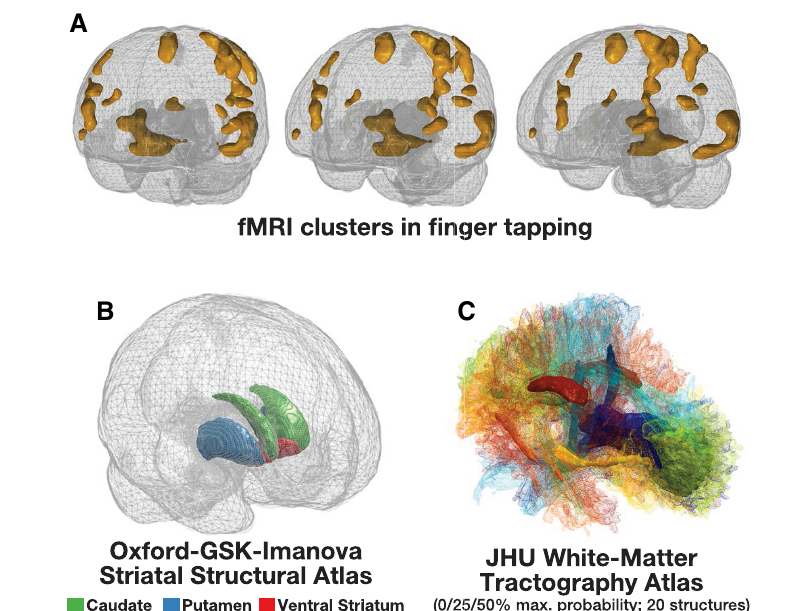
Figure 7. Additional examples of 3D renderings of MRI data. ( a ) Glass brain rendering of fMRI clusters associated with finger tapping, based on data from Gorgolewski et al. (2013), from three perspectives. ( b ) Glass brain rendering of the anatomical ROIs included in the Oxford-GSK-Imanova Structural Striatal Atlas ( c ) 3D rendering of the structures included in the JHU white-matter tractography atlas, with different mesh properties used for the 0%, 25%, and 50% probability estimates from the maximum probability volumes. See main text for additional details on the sources of the MRI